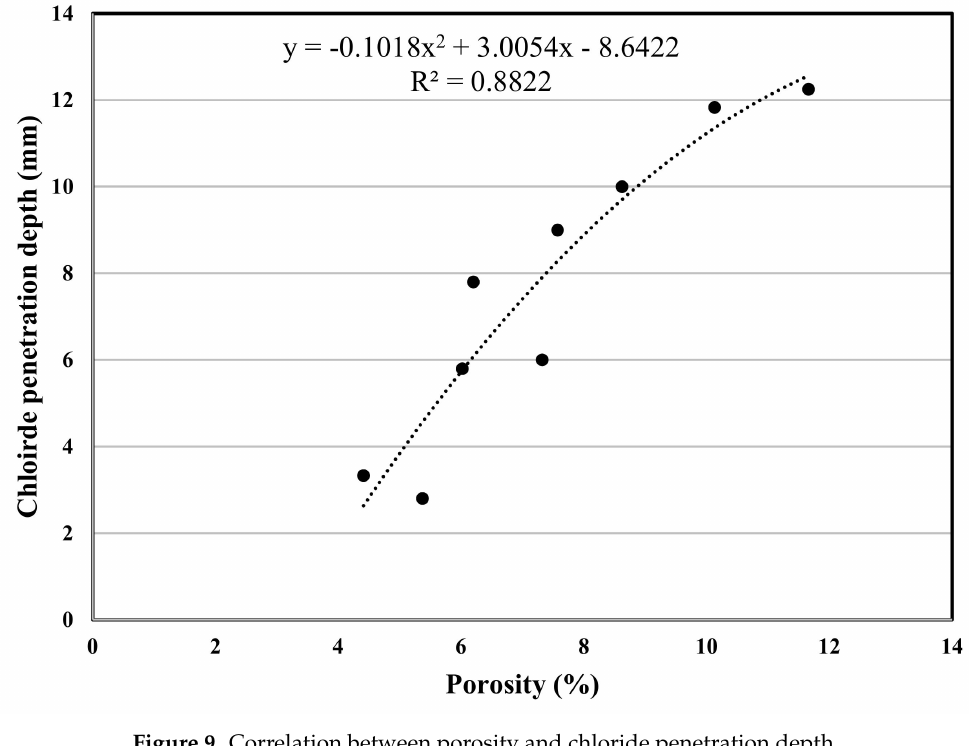
Figure 9. Correlation between porosity and chloride penetration depth.